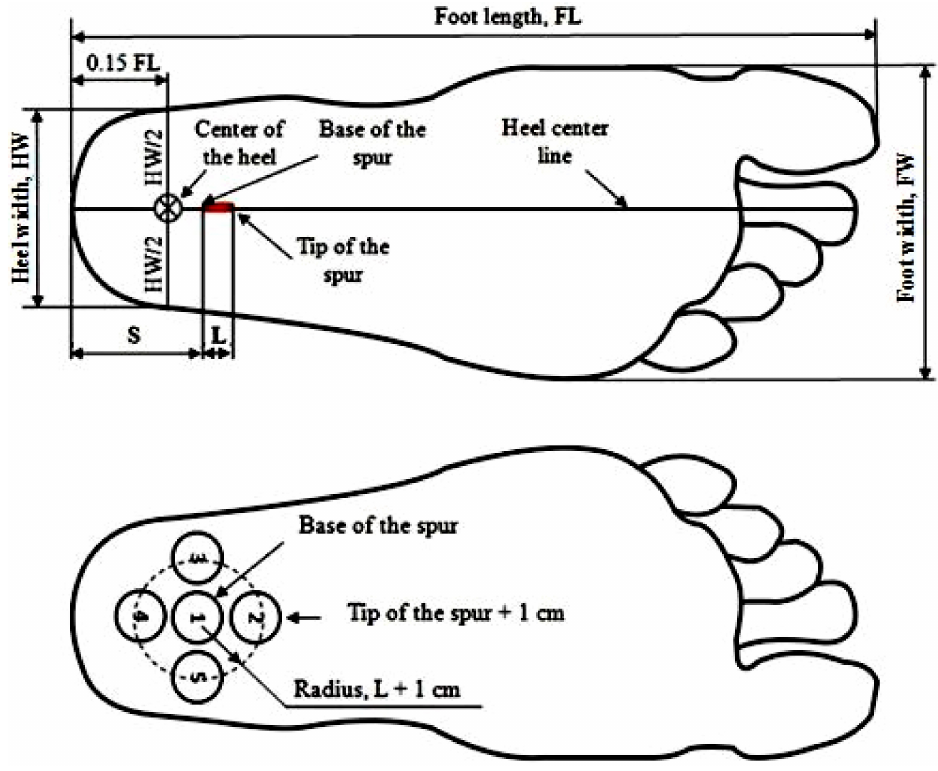
Figure 1. ( up ) Location and dimension of the spur in the plantar view; ( down ) Five locations of the pressure pain threshold (PPT) around spur